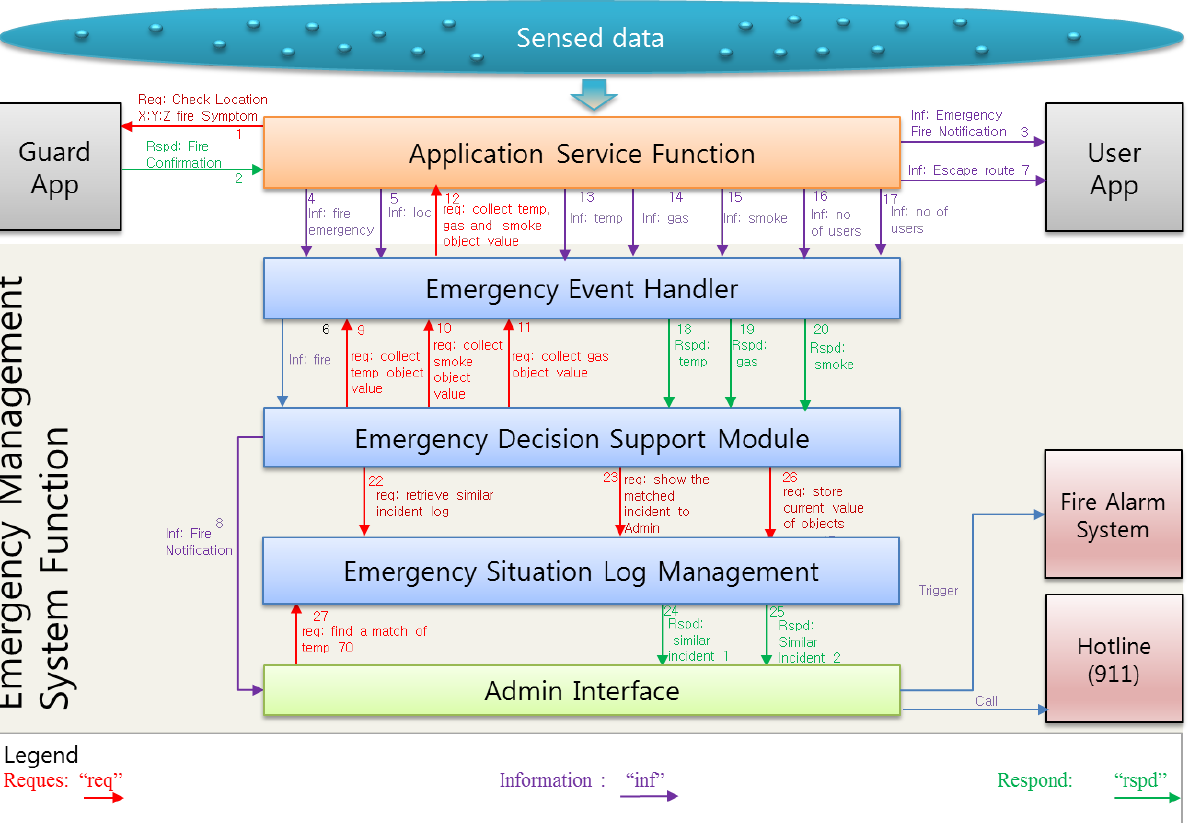
Figure 10. ASF rechecks the fire with the help of the guard, and notifies the EMSF and the user. The detailed message flow among all the modules during an emergency fire incident is shown in the diagram. After getting the confirmation on an admin interface, the concerned person triggers the fire alarm and calls the hotline for